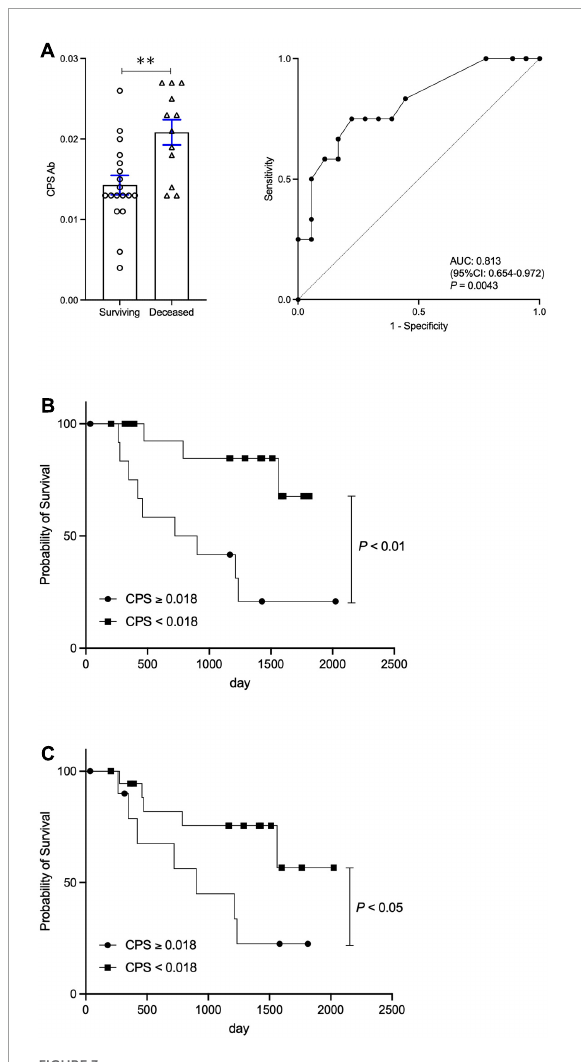
FIGURE3 Change in E. CPS antibody titer after rifaximin treatment and survival. (A) Surviving vs. deceased and Receiver operator characteristic analysis of survival curves, (B) survival curves of low and high E. CPS antibody titer at baseline, (C) survival curves of low and high E. CPS antibody titer at both 3 and 6 months post-rifaximin treatment. E. CPS, E. faecalis capsular polysaccharide; AUC, area under the curve; CI, confidence interval. ∗∗ p <